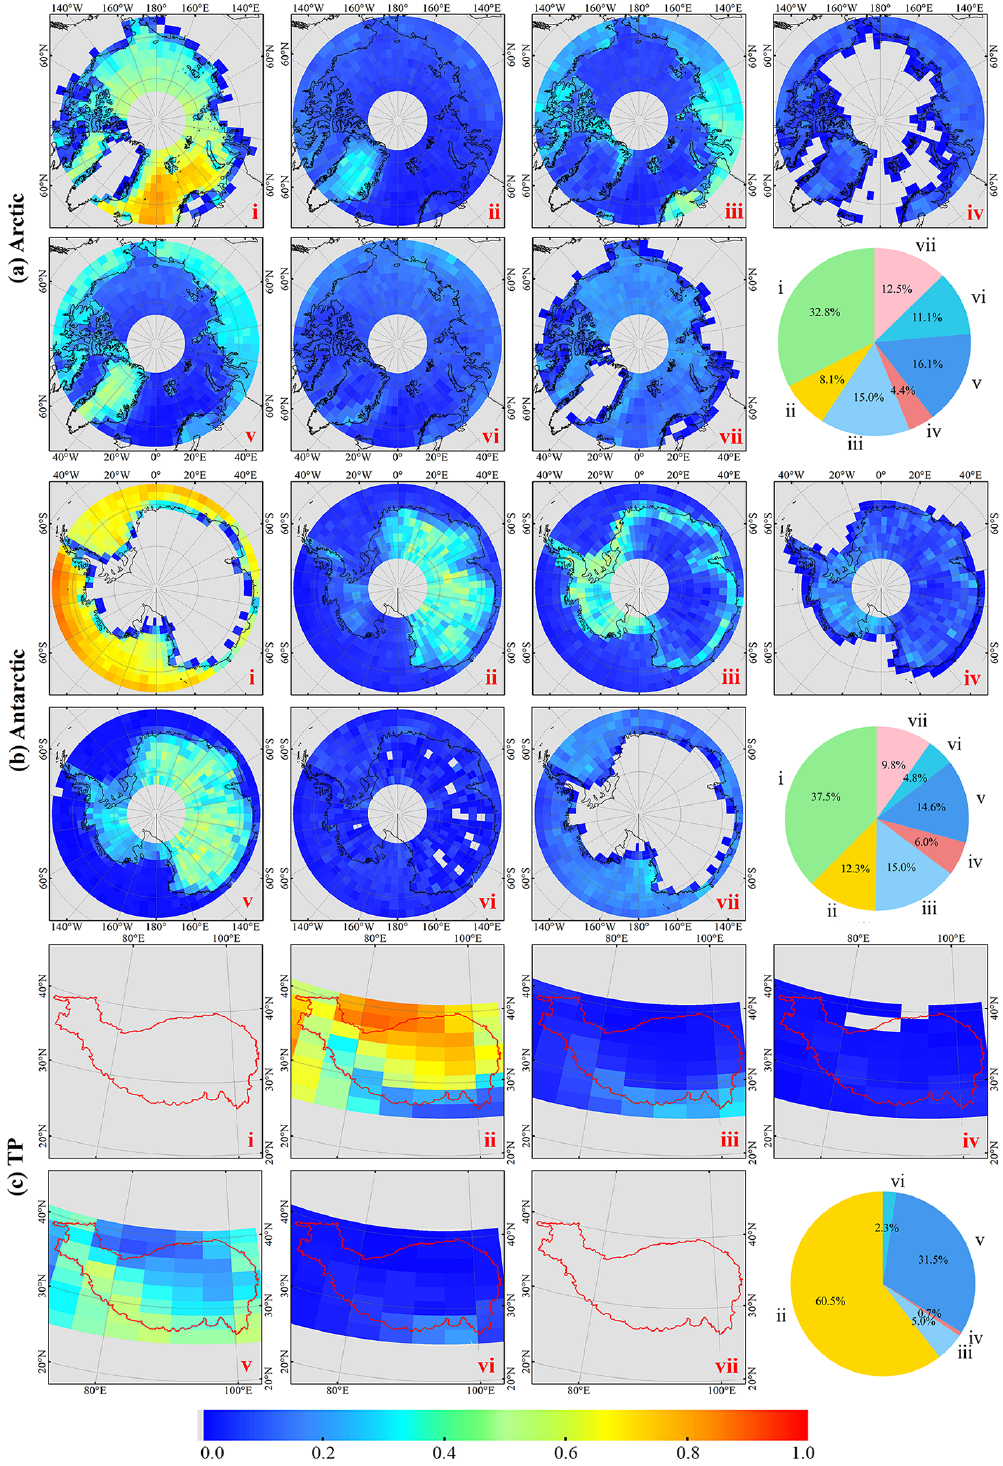
Figure 5. The annually averaged OF maps during the study period from June 2006 to December 2019 for seven aerosol types defined by CALIOP products over the (a) Arctic, (b) Antarctic and (c) TP. The numbers i–vii represent clean marine, dust, polluted continental/smoke, clean continental, polluted dust, elevated smoke and dusty marine, respectively. The pie represents the annual-average OF of all pixels for seven aerosol